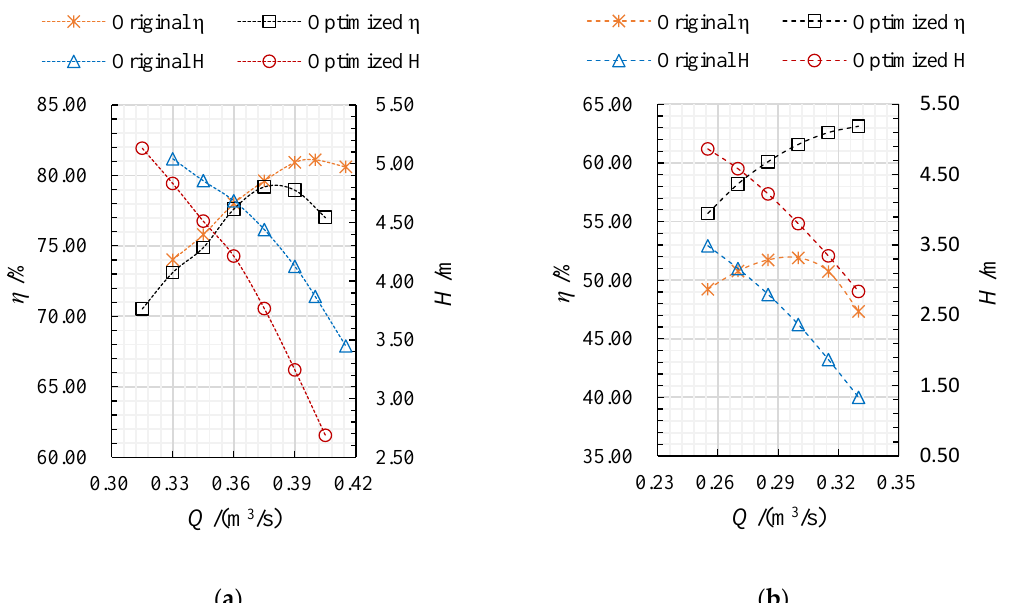
Figure 11. Comparison of pump performance between the original and optimized design: ( a ) under the forward condition and ( b ) under the reverse condition.